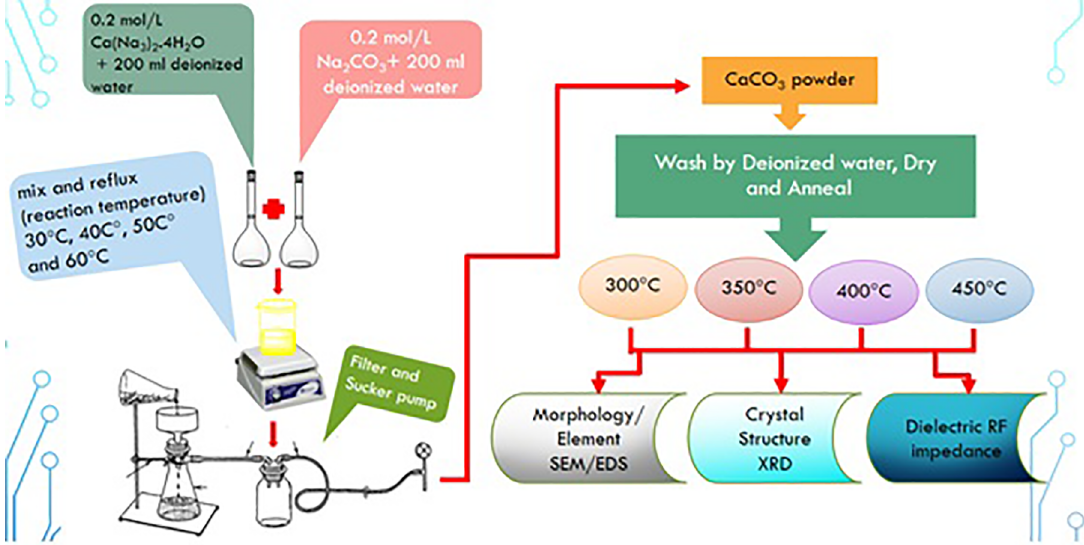
prepared by the precipitation 3